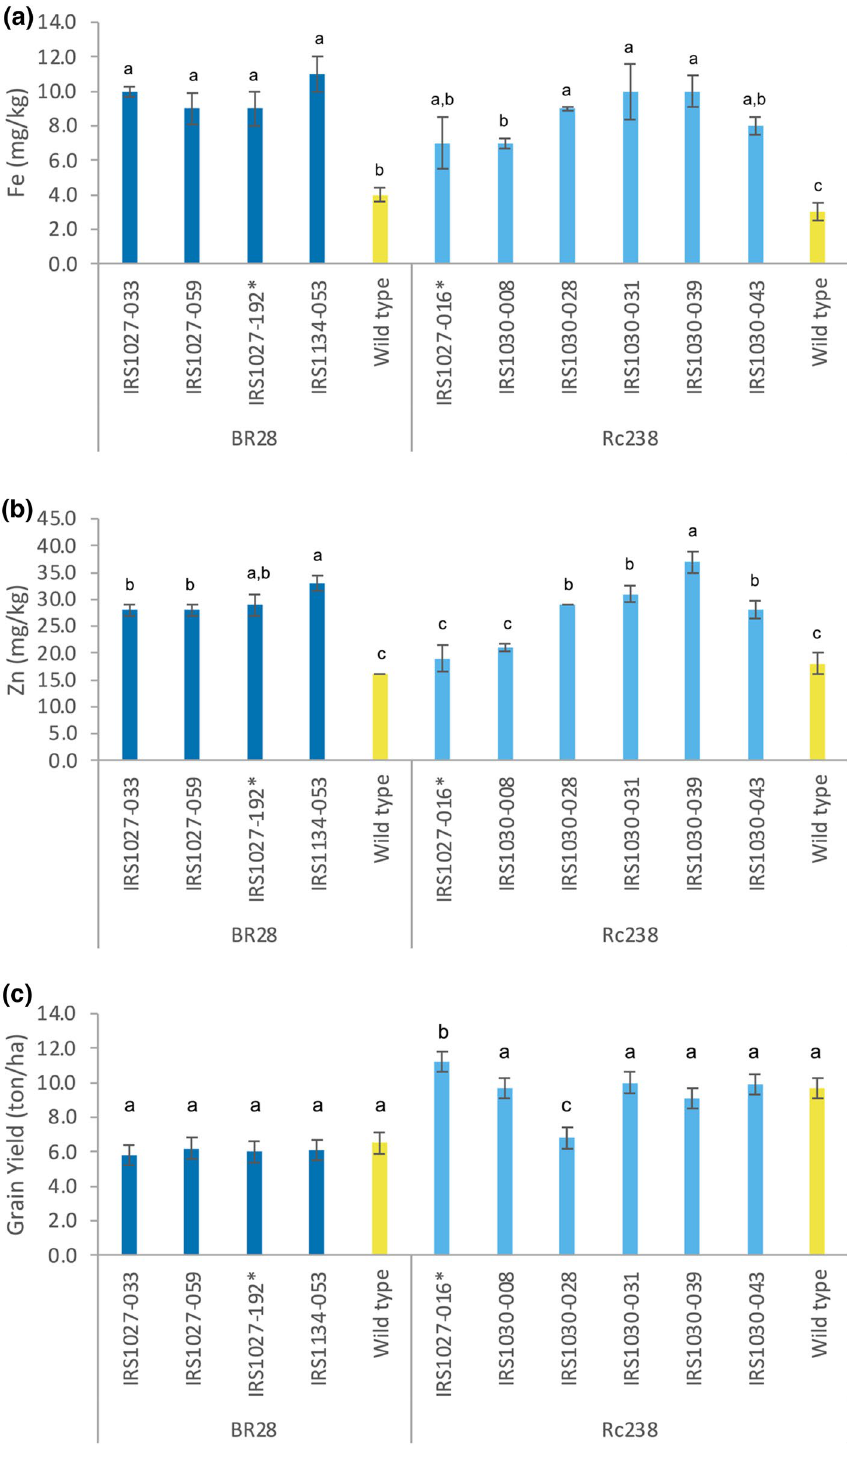
Figure 7. Fe ( a ) and Zn ( b ) elemental data of polished rice grains from BC 2 F 2 transgenic events in cv. BR28 and cv. Rc238 backgrounds, as well as their respective non-transformed controls, grown under field conditions at IRRI (Philippines). Means labeled with different letters differ significantly at the 5% level (Student’s T test). Grain yield ( c ) of candidate events in cv. BR28 and Rc238 genetic background. Data were collected from a confined test on the field conducted during 2017 of BC 2 F 2 homozygous HIZR candidate transgenic events in cv. BR28 and cv. Rc238 backgrounds and control non-transformed BR28 and Rc238, as well as the azygous controls for the respective backgrounds. Four replications were included in the field trial. The values represent the mean ± standard error (SE) across 6 different plants from each event. Data were subjected to a two-way analysis of variance (ANOVA) using entry and phenotypic parameters as factors. Means joined by the same letter group per respective background are not significantly different. Statistical significance was set at 5% level ( p <